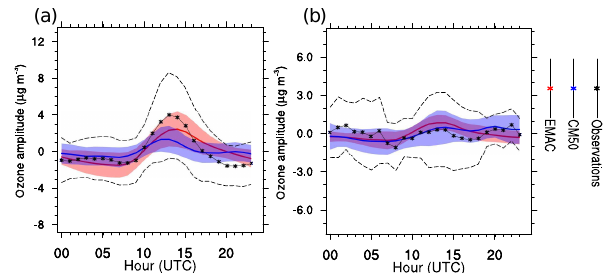
Figure 12. The same as Fig. 10 but for December 2008.